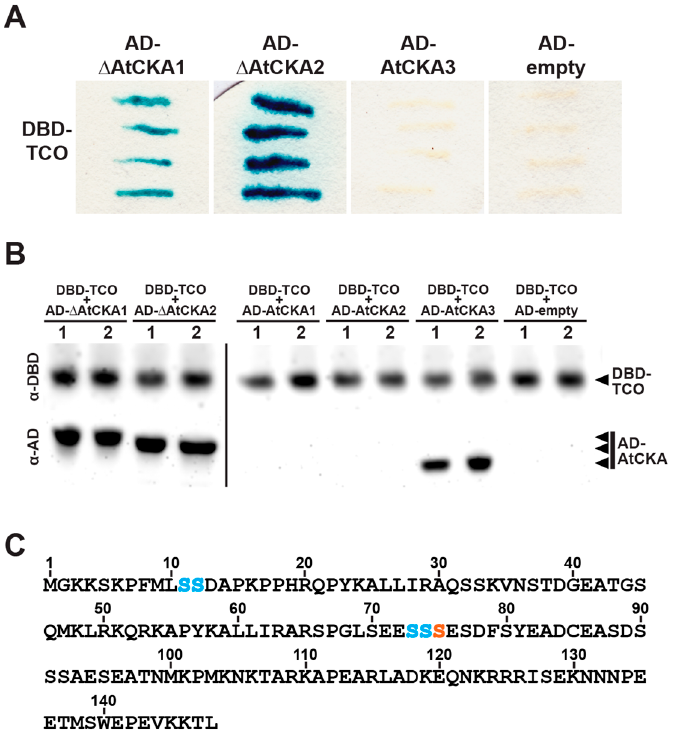
Figure 6. TCO protein interacts with catalytic subunits of the protein kinase CK2. ( A ) Yeast two-hybrid assays testing interaction between TCO (fused to the GAL4 DNA-binding domain (DBD)) and ∆ AtCKA1(aa25-409), ∆ AtCKA2(aa32-403) and AtCKA3(full-length) (each fused to the GAL4 activation domain (AD)), and an empty AD vector control are depicted. Positive interactions are indicated by blue coloration. ( B ) Western blot showing expression levels of yeast two-hybrid constructs. DBD-TCO, AD- ∆ AtCKA1(aa25-409), AD- ∆ AtCKA2(aa32-403) and AD-AtCKA3(full-length) show efficient expression in yeast. Full-length AD-AtCKA1 and AD-AtCKA2 protein does not accumulate to appreciable levels. The AD-empty vector control protein is not visible due to its small size. Two independent yeast transformants are shown for each vector combination. ( C ) Amino acid sequence of TCO. Serine (S) residues that reside within a putative consensus CK2 recognition sequence (SXXE/D) (orange) or that were experimentally determined to be modified by CK2 in this study (blue) are indicated.